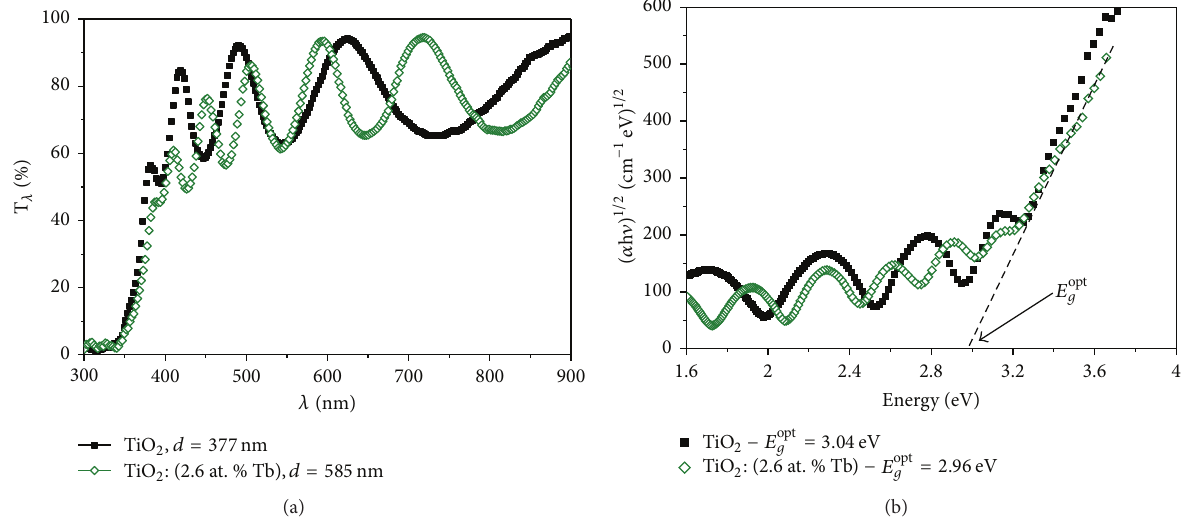
Figure 3: Optical properties of TiO 2 and TiO 2 :Tb:(a) transmission characteristics and (b) Tauc plots for allowed indirect transitions. 𝑑 : thin film